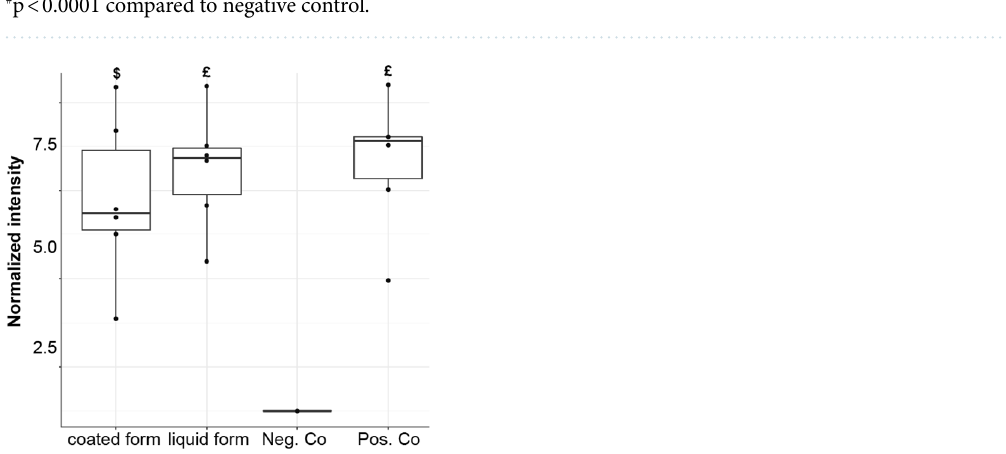
Figure 5. Fluorescence intensity of InViS after contact with an antiviral coating. Both the liquid and coated form of an antiviral coating solution (patent number PCT/EP2021/060580 30 ) lead to a significant increase in fluorescence, indicating virus capsule disintegration. Fluorescence levels of the intact InViS in PBS and InViS incubated with OEG served as negative and positive control, respectively. Results represent the median and corresponding standard deviations from three independent experiments with two technical replicates. $ p < 0.01 and £ p < 0.001 compared to negative